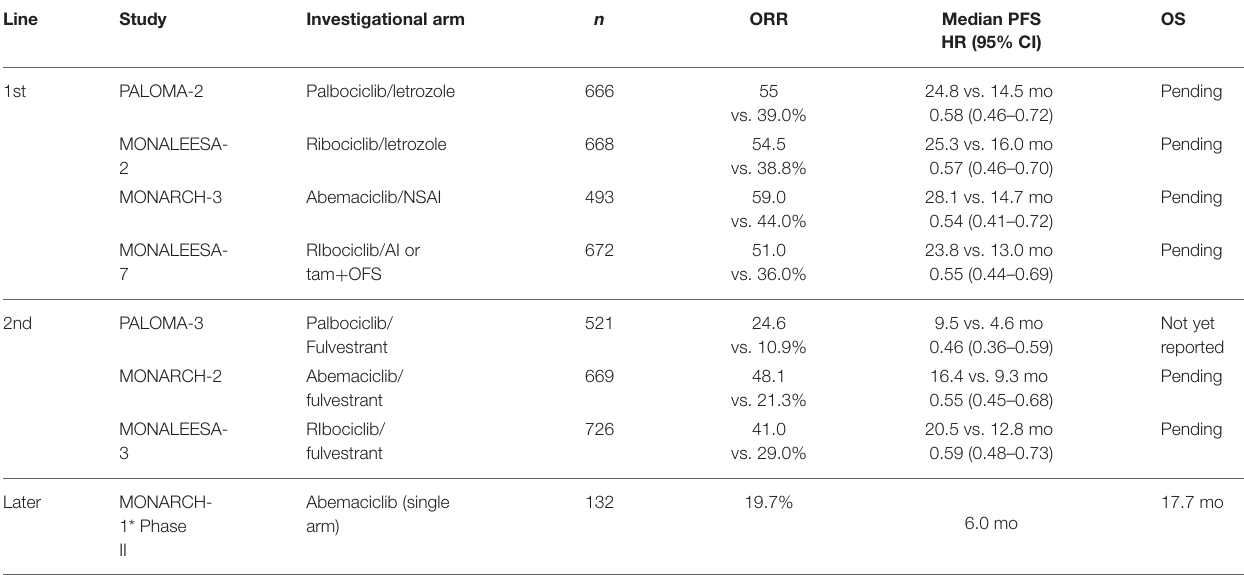
TABLE 2 | Summary of phase III clinical trial results for CDK4/6 inhibitors in metastatic HR positive, HER2 negative breast cancer.